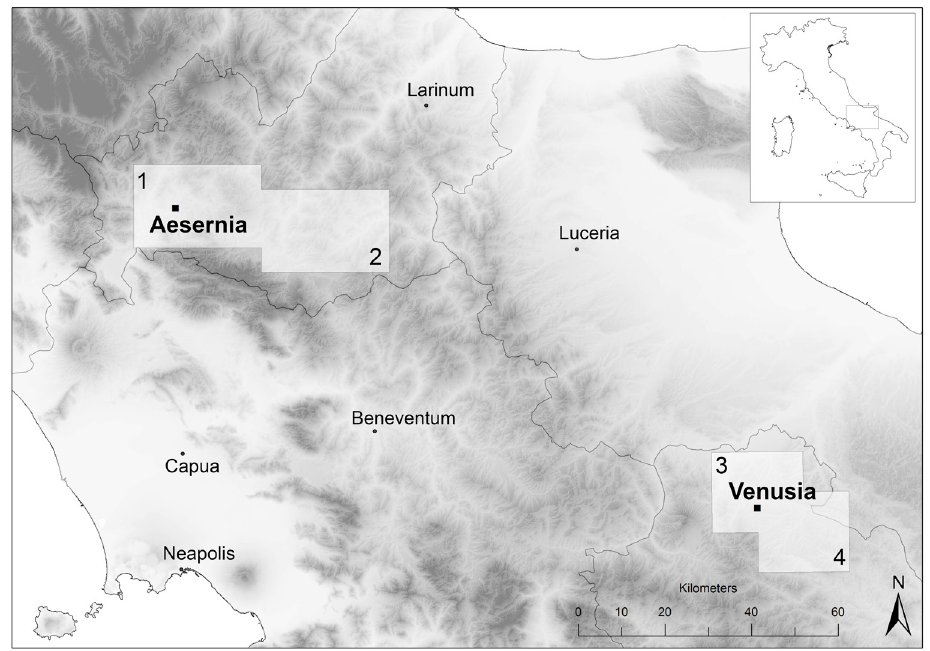
Figure 1: LERC research areas in 1, Aesernia; 2, Tappino valley and 3,